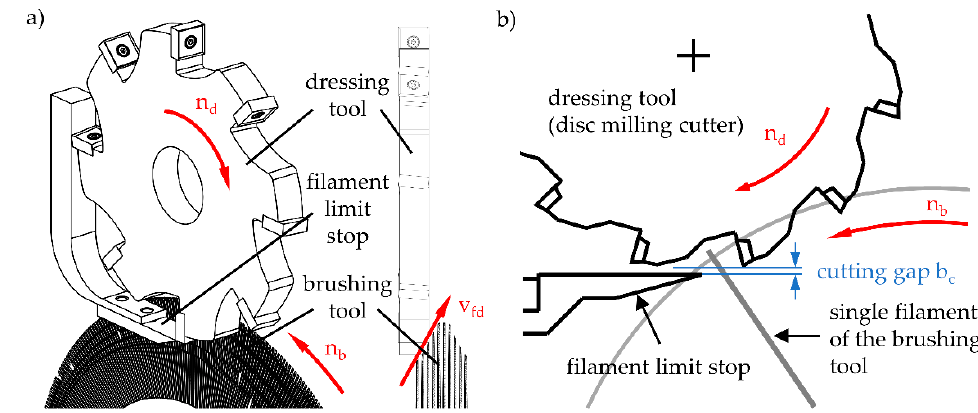
Figure 14. Schematic illustration of the concept for machine ‐ integrated conditioning of abrasive brushes; ( a ) 3 ‐ D representation of the design concept; ( b ) Illustration of the kinematics used to trim the brush filaments.